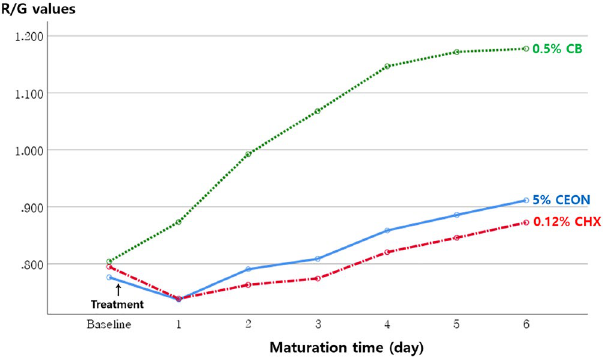
Figure 2. Changes in R/G values of oral biofilms formed in the presence of three treatment solutions according to maturation time. CEON cinnamon essential oil nanoemulsion, CHX chlorhexidine gluconate, CB cocamidopropyl